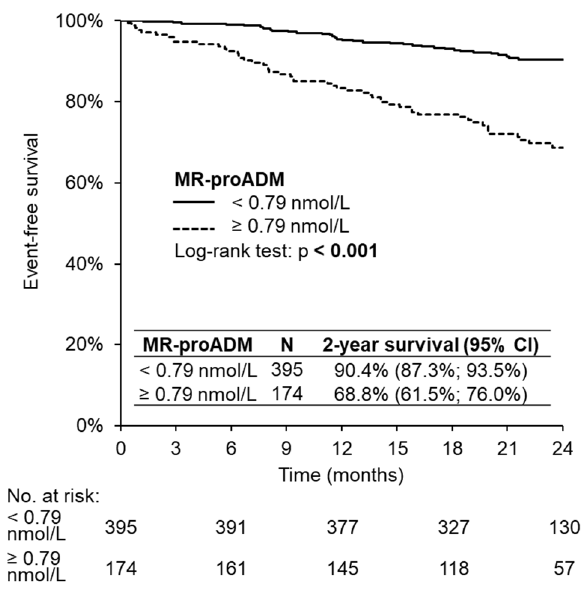
Figure 2. Two-year event-free survival.